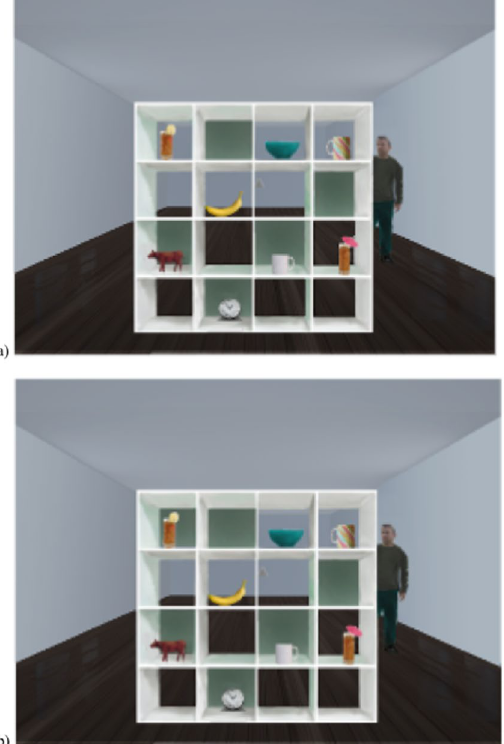
Figure 1. Example stimuli from the referential communication task, to be paired with the instruction, “Move the glass with the umbrella in down”. Panel (a) shows an example scene in the Shared Perspective condition (i.e. both the target and competitor objects are visible to both speaker and participant), and panel (b) shows an example scene in the Listener Privileged condition (i.e. only the target object is visible to both speaker and